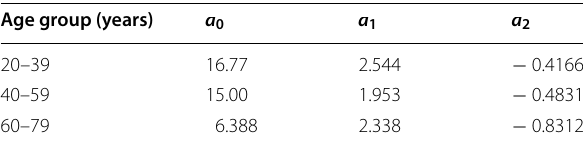
Table 2 Resultant coefficients of the risk curve for three generations, fitted to Eq. 8